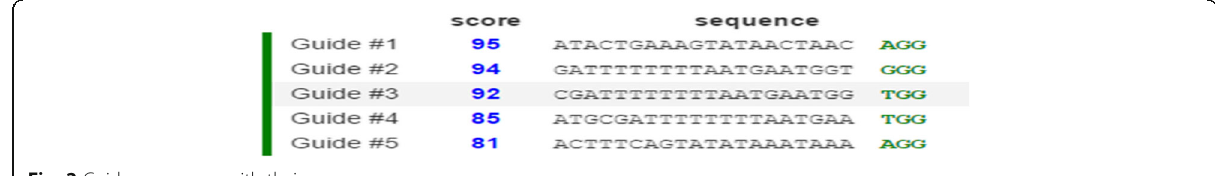
Fig. 2 Guide sequences with their